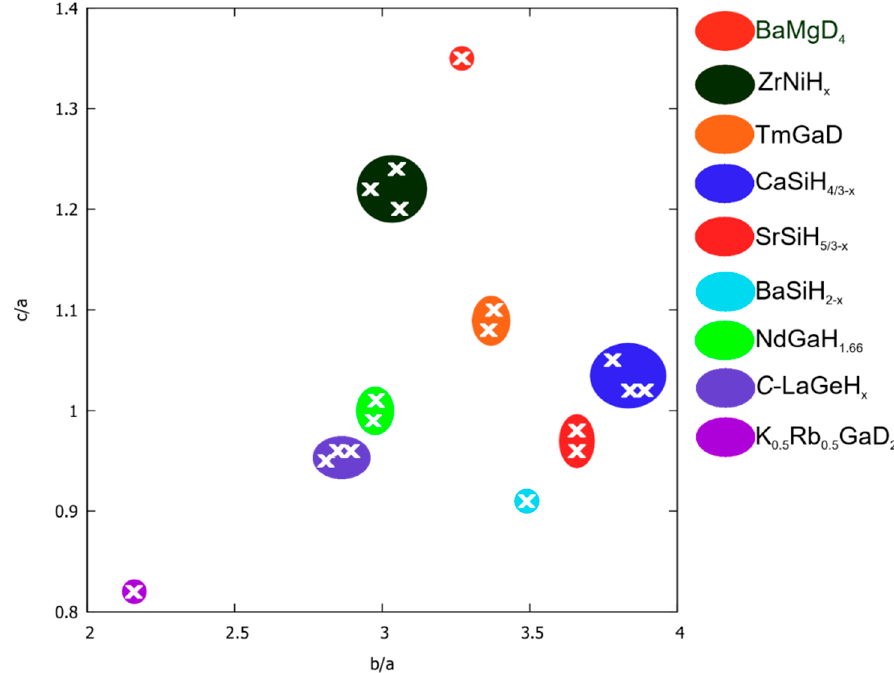
Figure 8. Structure map of different CrB type related hydrides regarding their lattice parameter ratios with different structure families indicated by colored areas; representatives listed in Table 4. Table 4. Lattice parameter ratios of selected hydrides with crystal structures related to the CrB type.